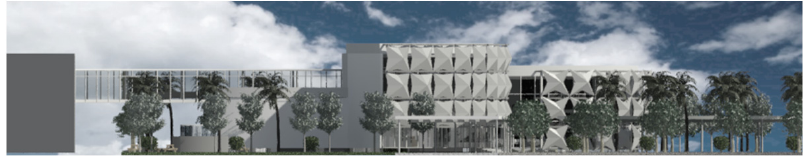
Figure 14. West elevation.